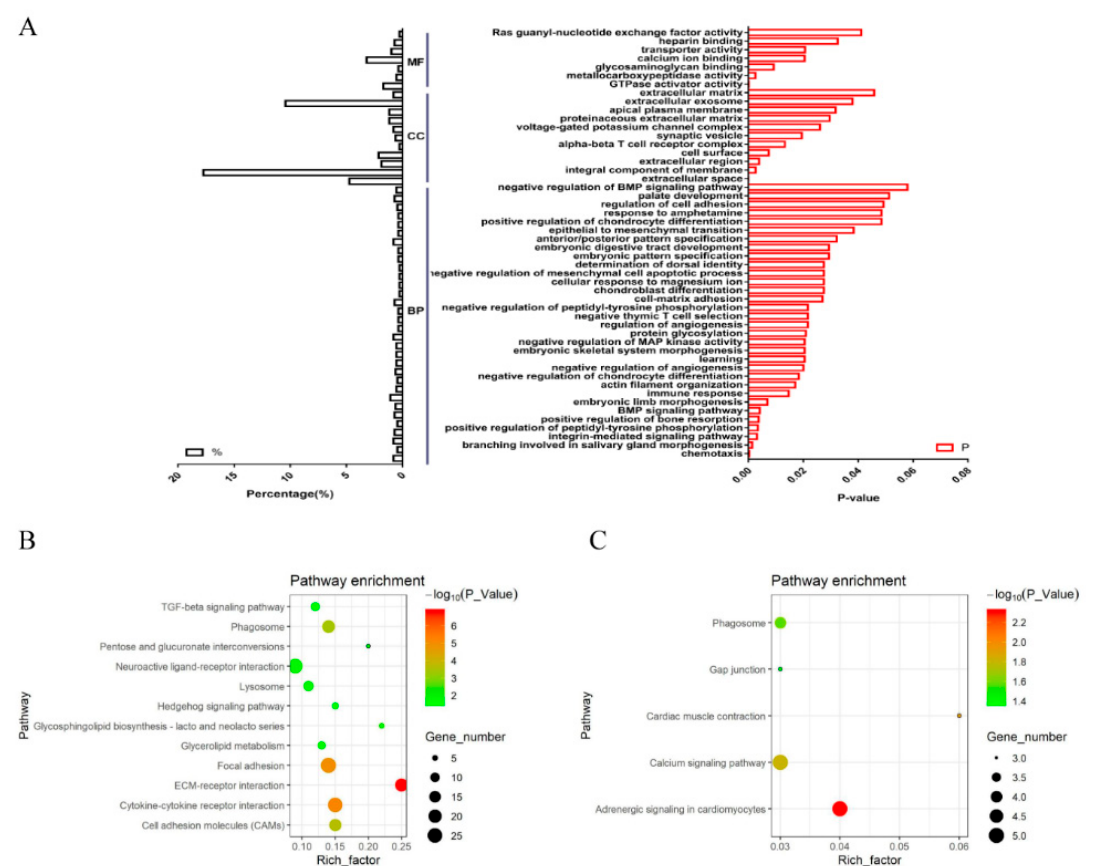
Figure 5. Enrichment analysis of DEGs between the calcified and un-calcified groups in the sternum and pectoral muscles. ( A ) Gene ontology (GO) annotation of differentially expressed genes (DEGs) in sternum. ( B ) Kyoto Encyclopedia of Genes and Genomes (KEGG) enrichment scatter plot of DEGs in the sternum. ( C ): KEGG enrichment scatter plot of DEGs in pectoral muscles. All DEGs in the sternum and pectoral muscles were compared between the calcified and un-calcified groups.